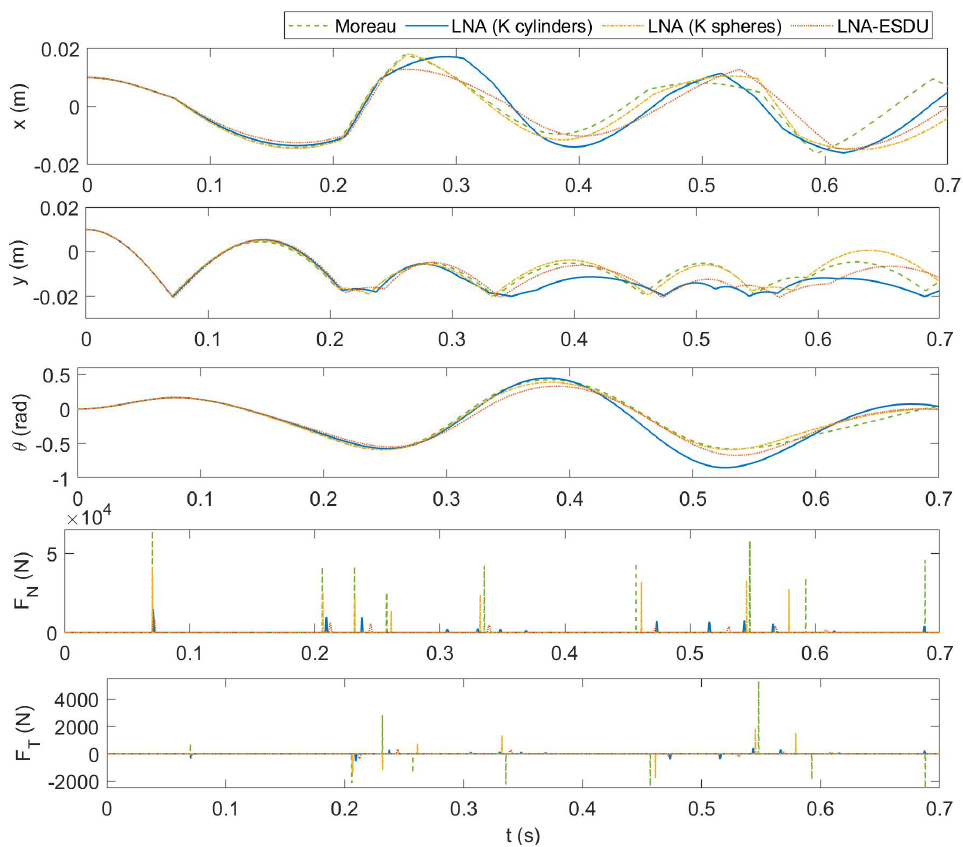
Figure 11. CSFH simulation—comparison of the four models: from the top to the bottom: x -coordinate of G 1 , y -coordinate of G 1 , rotation angle θ of body 1, normal contact force F N , tangential friction force F T